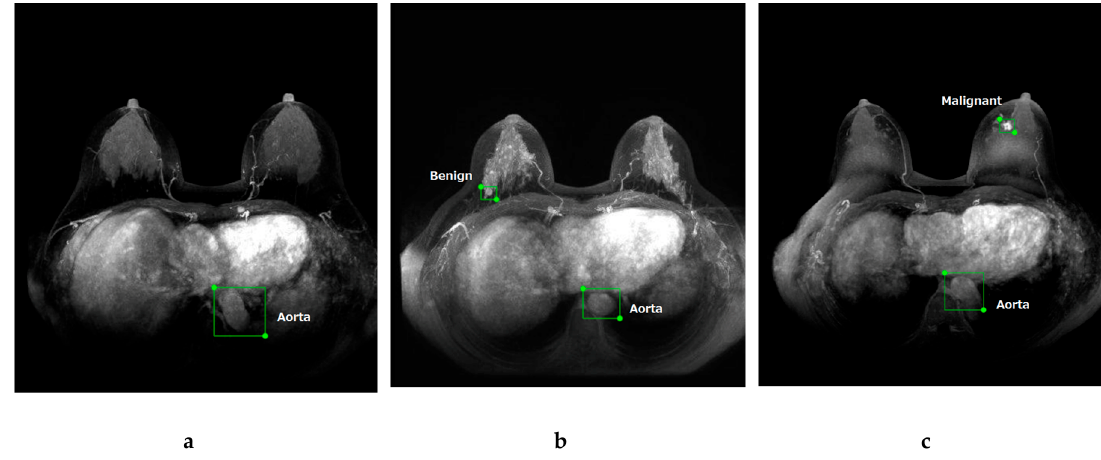
Figure 1. Maximum intensity projection of dynamic contrast-enhanced breast magnetic resonance images. Representative images of labeled normal ( a ), benign ( b ), and malignant ( c ) breast